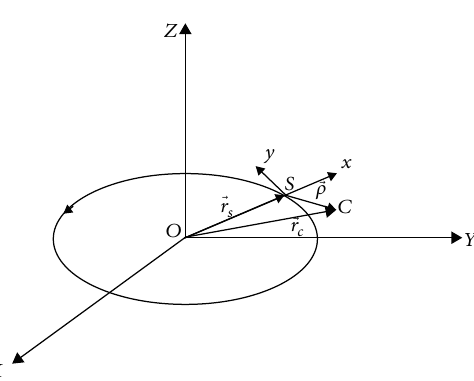
3: The relative motion coordinate system and the Earth ’ s inertial coordinate